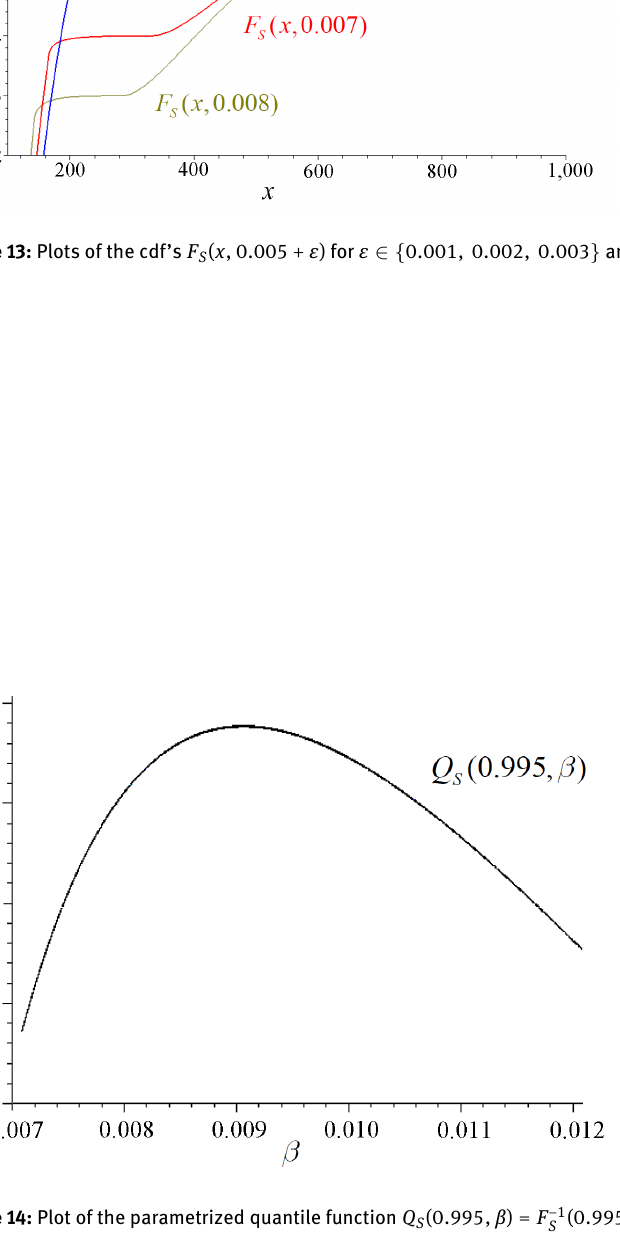
Figure 14: Plot of the parametrized quantile function Q S (0.995, β ) = F −1